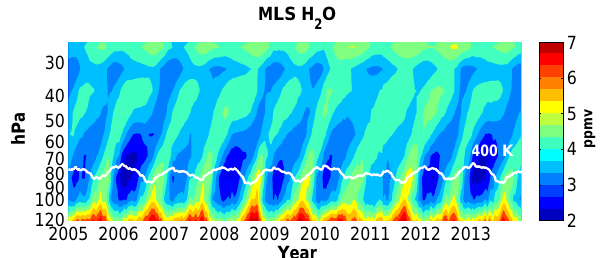
Figure 1. The zonal mean tropical (10 ◦ S–10 ◦ N) tape recorder sig- nal of water vapor (the colored mixing ratio in ppmv) from the MLS observations. The white line marks the 400K isentrope for refer-